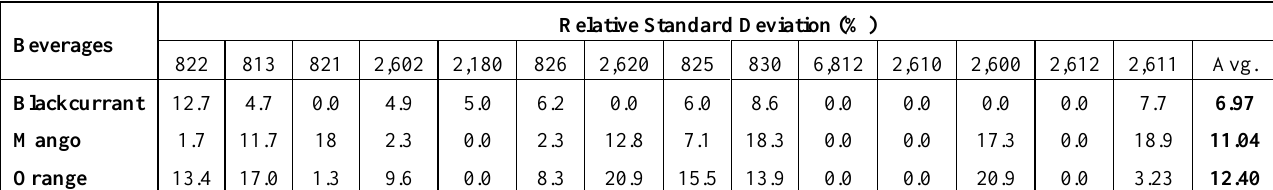
Table 3. The r values obtained for 10 measurements of blackcurrant, mango and orange juices. Beverages